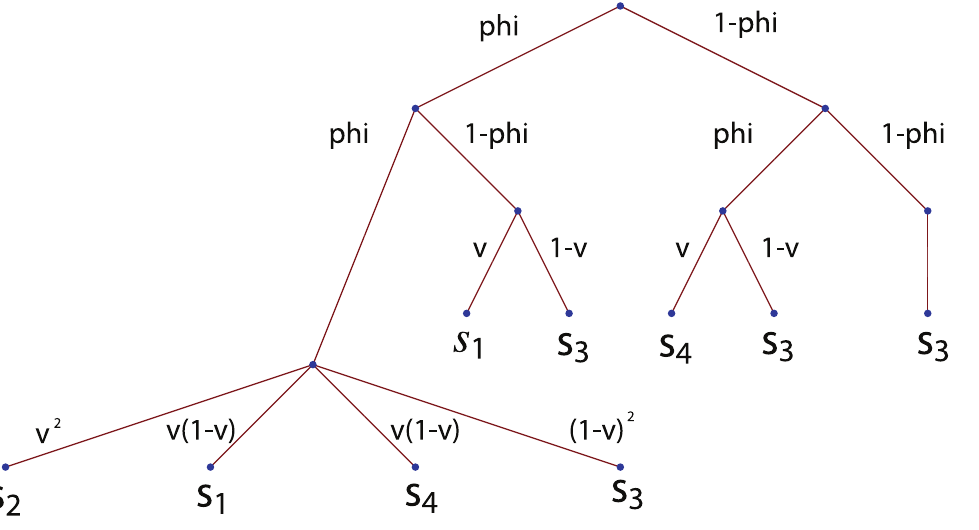
Figure 1. Demographic outcomes and events faced by the individuals in a focal group (the terms ‘‘outcomes’’ and ‘‘events’’ are used as defined in probability theory, e.g., p. 18, chapter 1 of [ 62 ] ). Each different connected series of edges starting at the root node (top of the figure) provides a demographic outcome. Different outcomes may lead to similar demographic events, which are denoted by s i and described in the text. The first series of edges, directly issued from the root node, represents the probabilities that the focal group fights or does not fight to conquer another group from the population. The second series of edges represent the probabilities that the focal group fights or does not fights locally. The third series of edges represent the winning probabilities of the various battles, which occur only if there is a fight. For instance, the left most series of connected edges represent the outcome where the focal group fights against another group upon attacking (probability w ), it fights locally because it is attacked (probability w ) and wins the two battles (probability v 2 ). In order to obtain the probabilities of occurrence of each demographic event describes in the text, one has to sum the probabilities of occurrence of outcomes where that event obtains, which gives Pr(